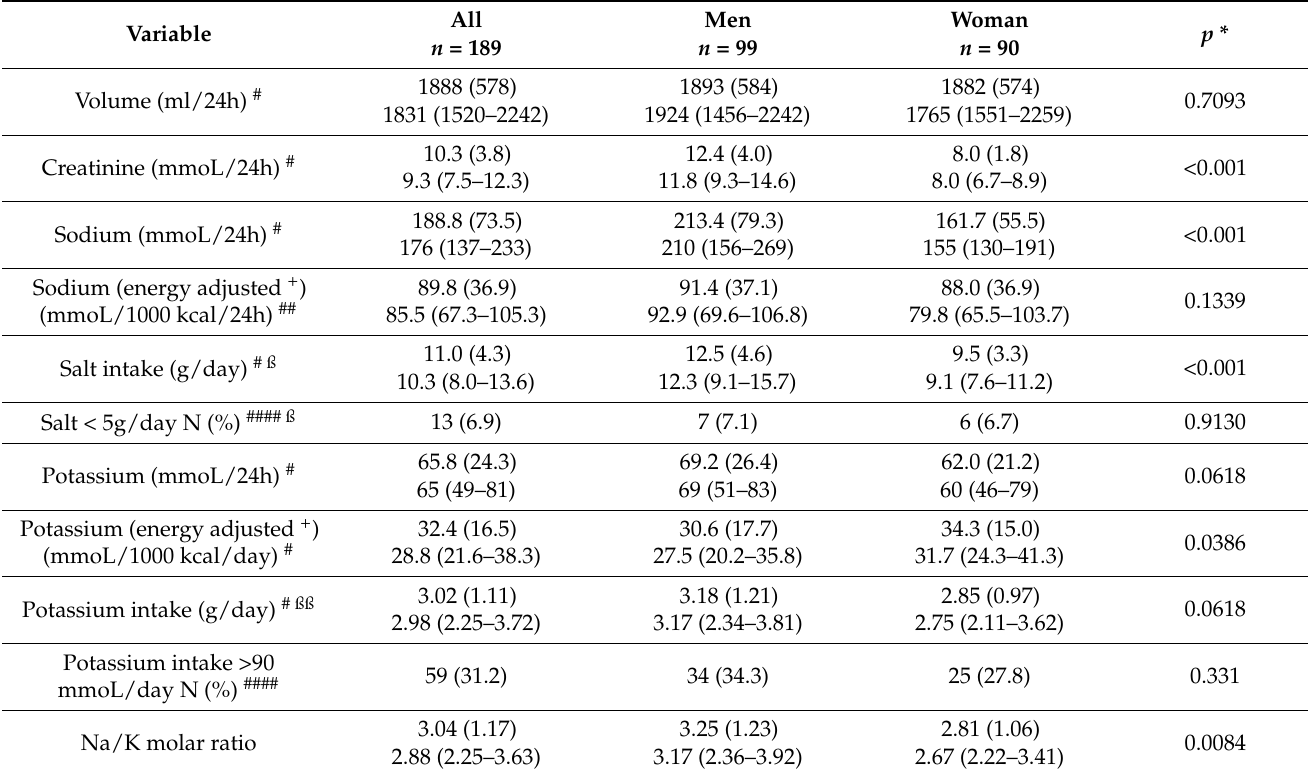
Table 4. Daily urinary excretions of volume, sodium, potassium and creatinine; estimates of salt and potassium intake; and proportion of participants meeting recommended targets for salt and potassium consumption, Biomarker2019